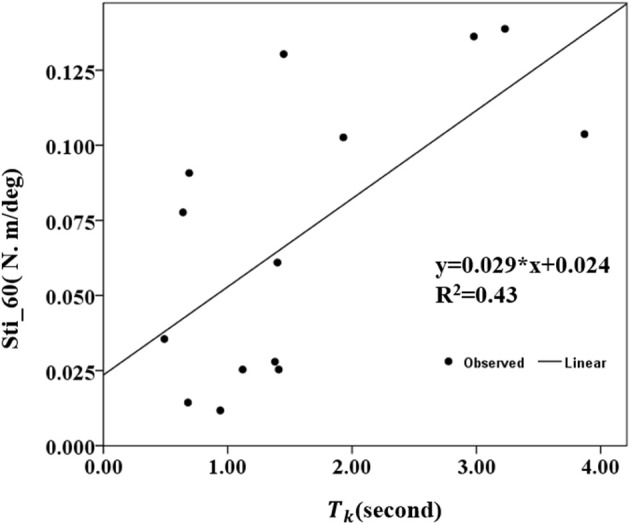
Conelation between the stiffness of 60°/s and the keep time (Tk) of the MIVC with linear regression analysis.